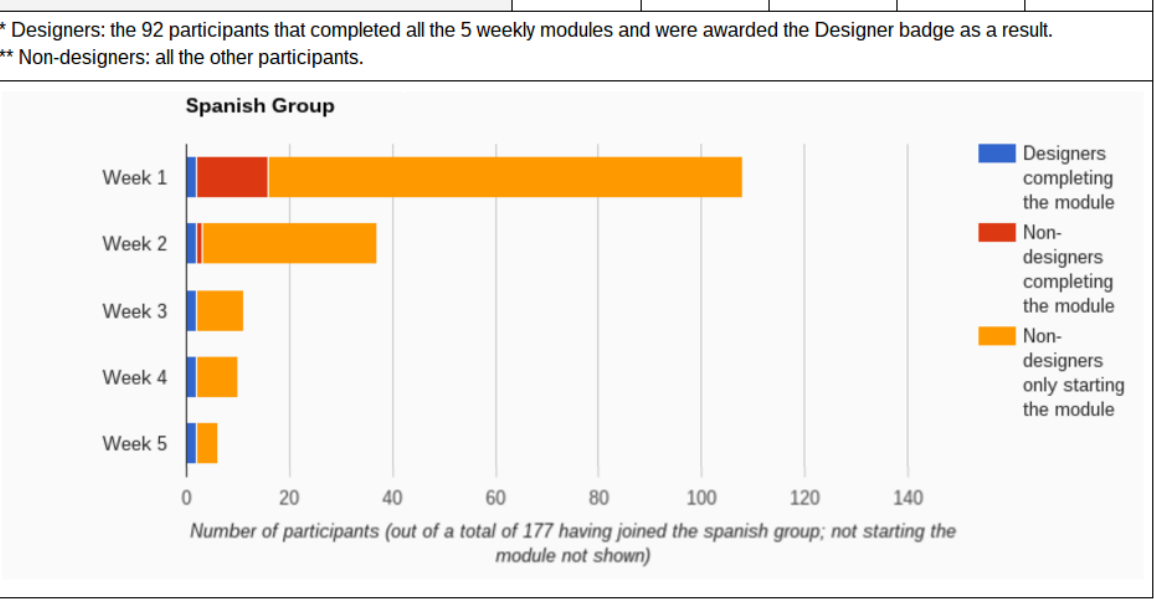
Figure 9 . Spanish group: Evolution of participation in weekly modules of activities. All seven groups showed the MOOC-wide decrease described above in the number of non-designers, but with some idiosyncrasies. Notably, the Greek non-designers only starting the module stood out from the rest of the groups, especially in week 1, as they represented only 37% of the total number of participants of the Greek group, while this proportion ranged from 46 to 63% in the other groups. Also, of the 109 non- designers completing modules recorded during weeks 1-4 for all groups, 43 (39.4%) were from the Catalan group. The most salient difference between language groups was however in the number of designers, most of them (80/92=87%) belonging to only three language groups, the Bulgarian, Catalan and Greek